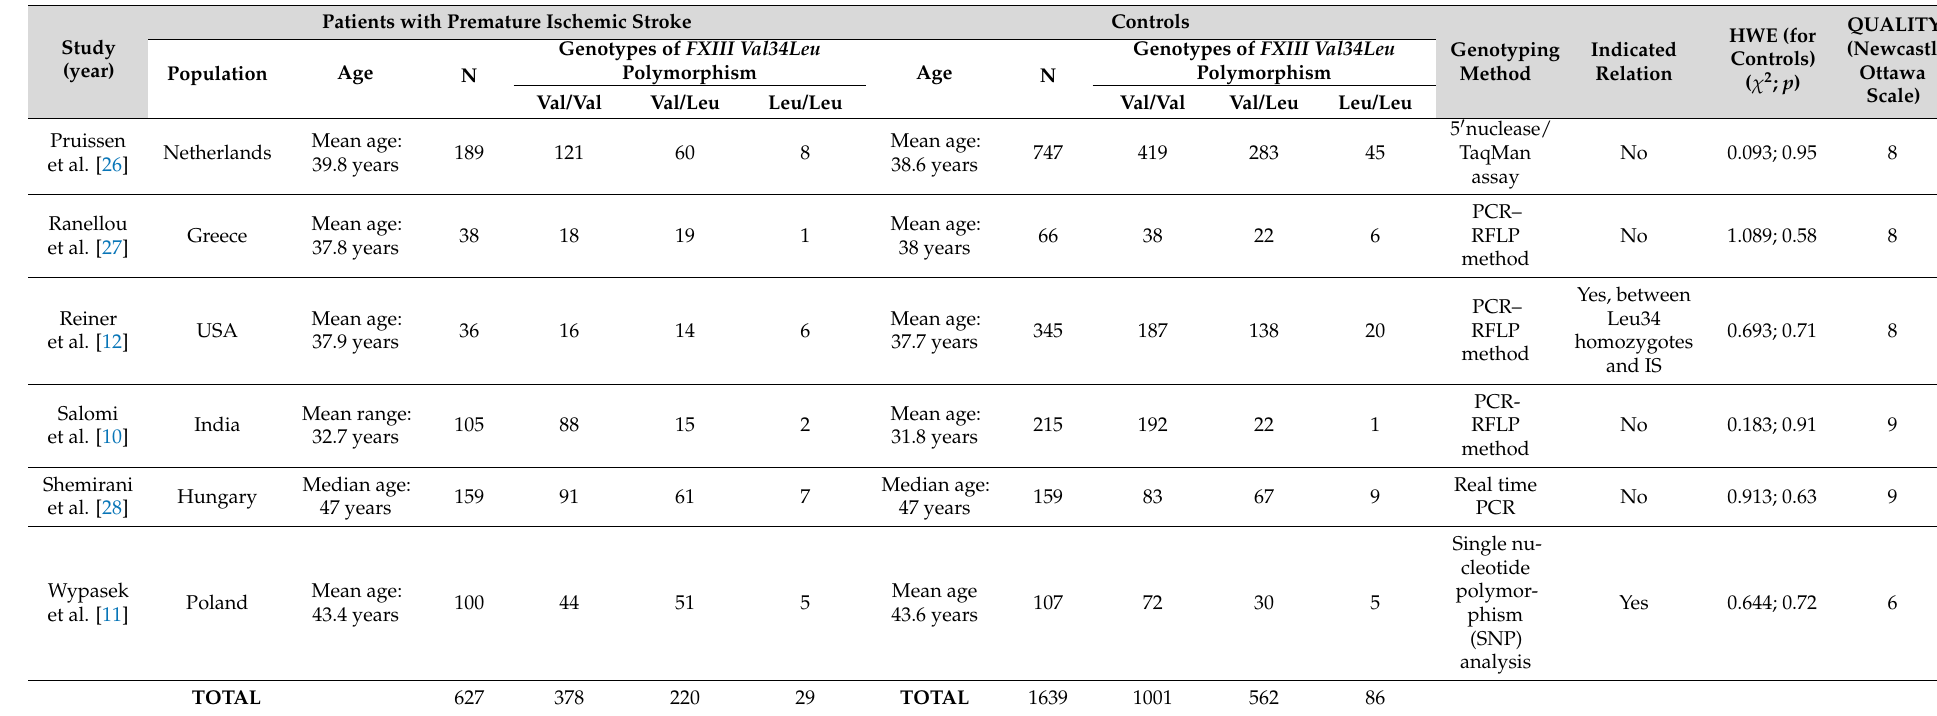
Table 1. Characteristics of the studies included to the meta-analysis regarding the relation between FXIII Val34Leu polymorphism and IS in young adults. Patients with Premature Ischemic